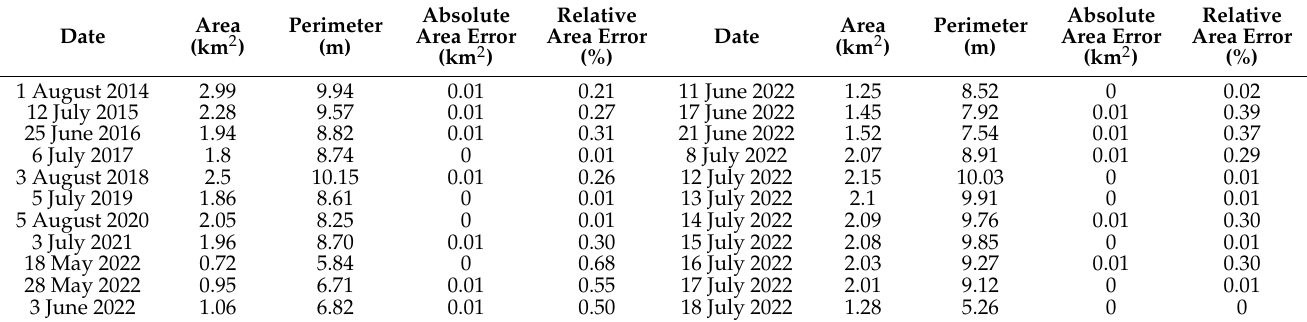
Table 4. Absolute and relative area error of Lake Merzbacher.